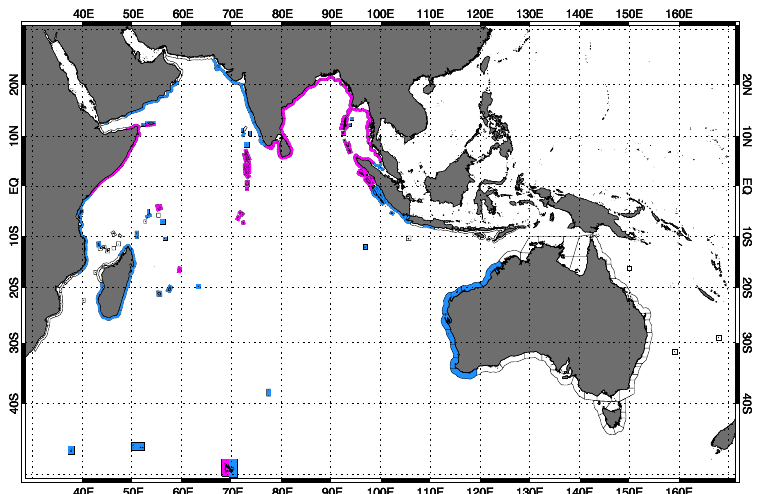
Fig. 14. Derived T2 warnings for the Sumatra 2004 event using the extended set of Indian Ocean coastal zones and the thresholds in Sect. 3.2. Coastal zones assigned marine and land threats are shaded in blue and magenta,